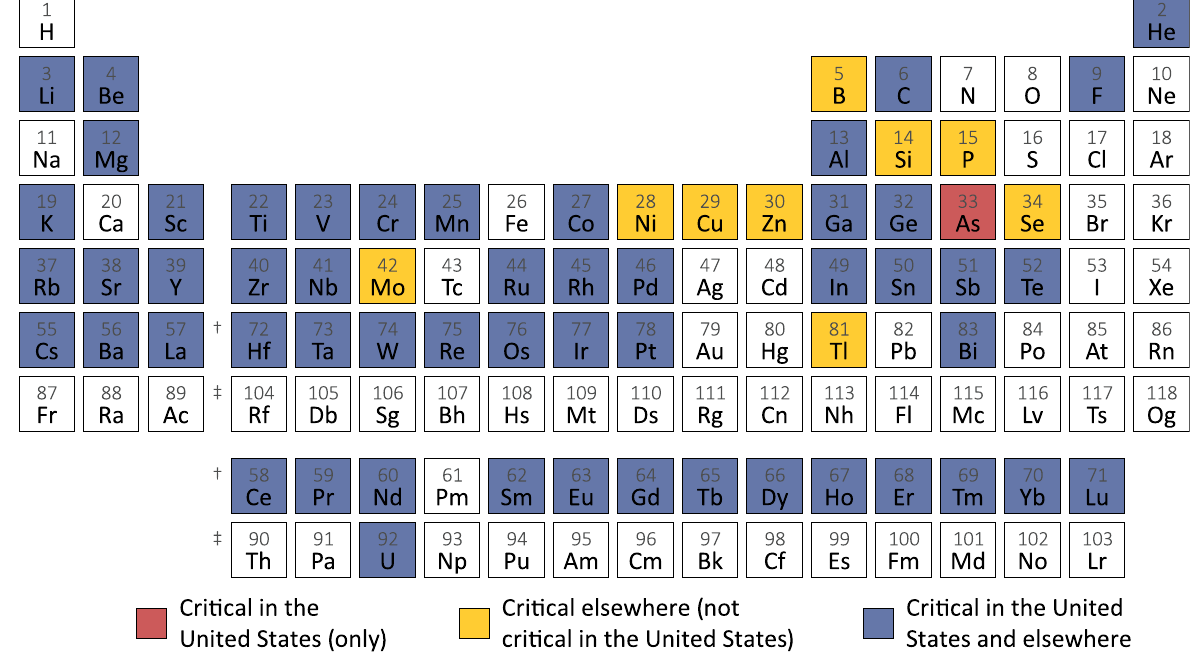
Fig. 1 Elements designated critical only by the U.S. Department of the Interior 11, only by other countries than the United States (European Union 9, Japan 14, Australia 12, and Canada 13), and by both the United States and other